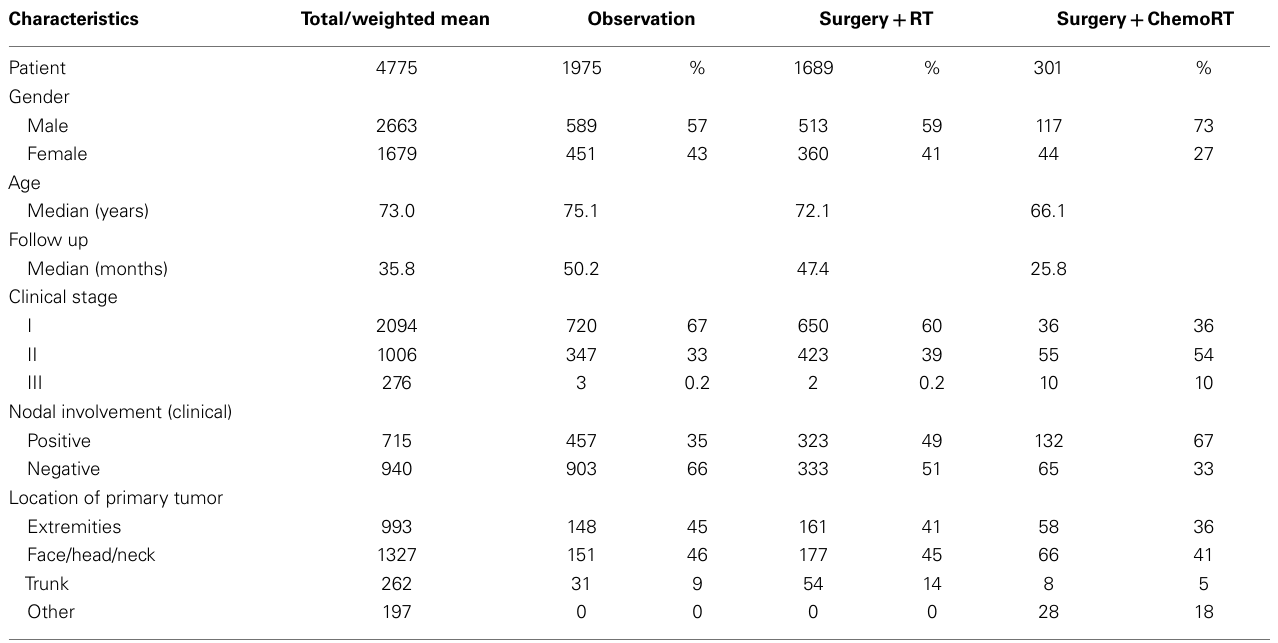
Table 1 | Summary of patient demographics.